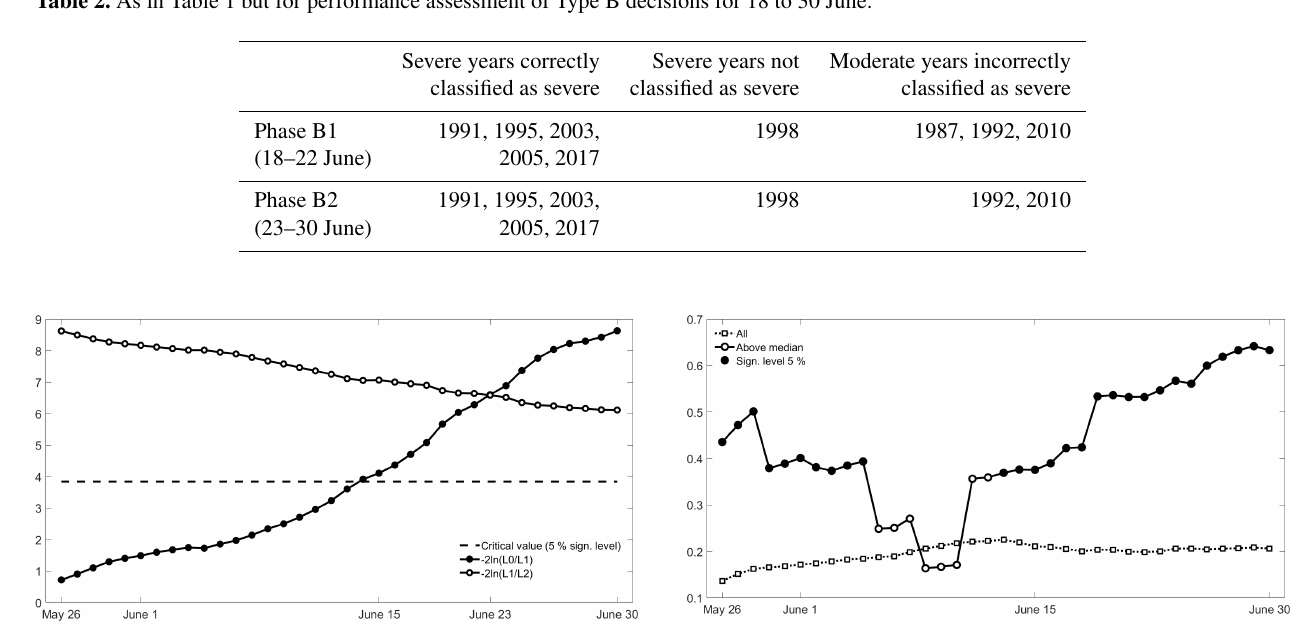
Table 2. As in Table 1 but for performance assessment of Type B decisions for 18 to 30 June.